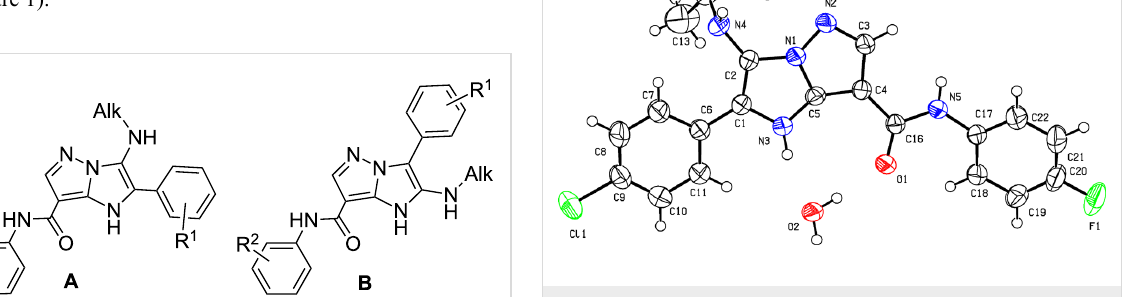
Figure 3: Molecular structure of 3-( tert -butylamino)-2-(4-chlorophenyl)- N -(4-fluorophenyl)-1 H -imidazo[1,2- b ]pyrazole-7-carboxamide ( 4e ) (X-ray diffraction data). Non-hydrogen atoms are presented as ther- mal ellipsoids with 50% probability. In the case of compounds 9 the presence of NOE between the signals of the methyl group and the CH group in the isoxazole moiety allowed to distinguish closely located signals of two CH groups (Figure 4).